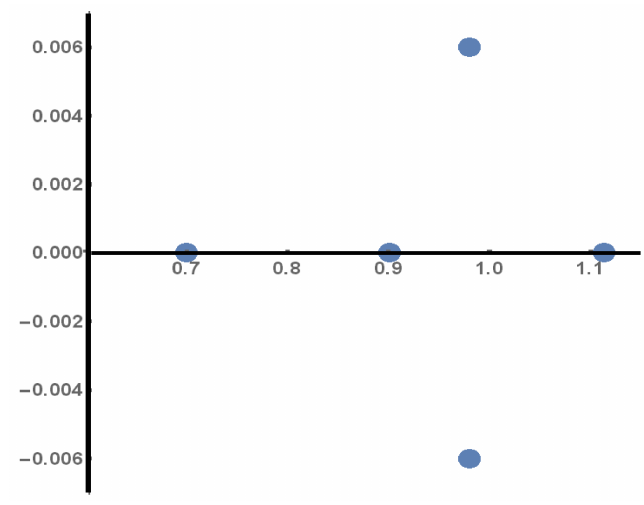
Figure 6. Eigenvalues of the 5 × 5 matrix produced by the EDMD methodology.